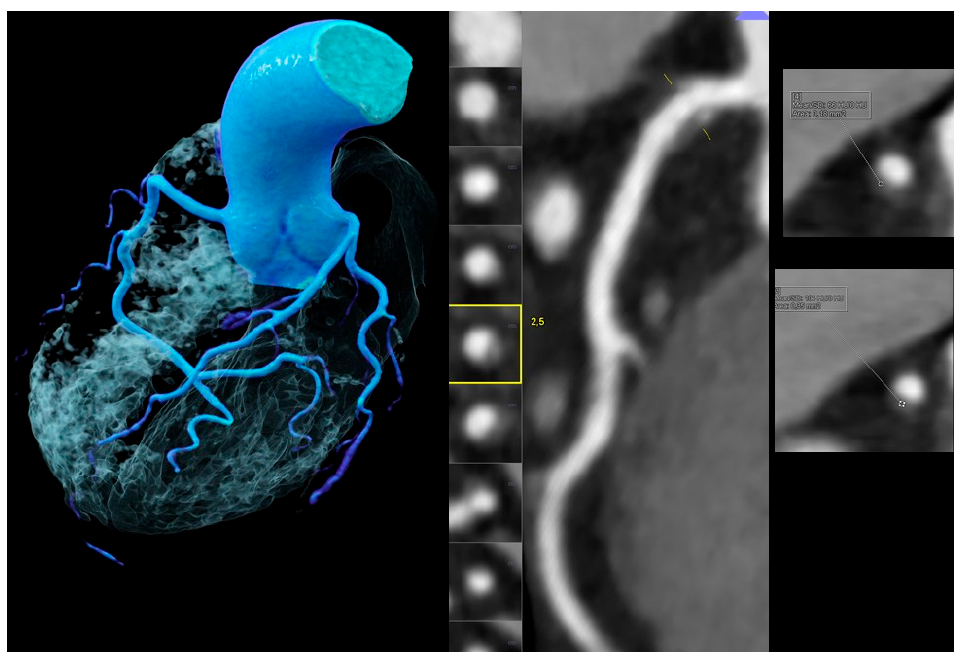
Figure 3. Images obtained for a 53-year-old male without chest pain but borderline ST-depression on electrocardiogram treadmill, a positive family history, and an elevated total cholesterol (234 mg/dL). Coronary artery calcium score (CACS) was zero but coronary CTA (left and mid panel, left volume rendering technique (VRT) and mid curved multiplanar reformation (MPR)) showed a mild (<50%) stenosis in the proximal right coronary artery (RCA) caused by a high-risk-plaque (HRP) with a hyperdense rim (napkin-ring sign (NRS) ( yellow square )) (right upper and lower panels) and a very small spotty calcification (SC), which was nondetectable by CACS.